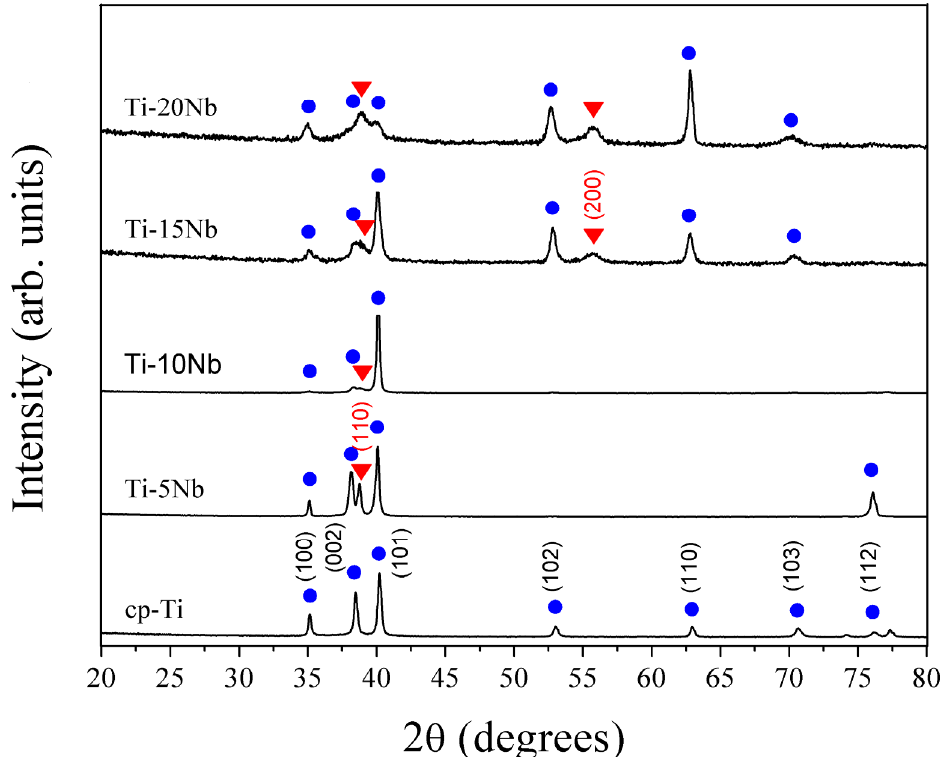
Figure 1. XRD patterns of cast cp-Ti and the series of binary Ti-xNb alloys. The hexagonal Ti and cubic β -Ti peaks are marked with bullet and İ symbols,